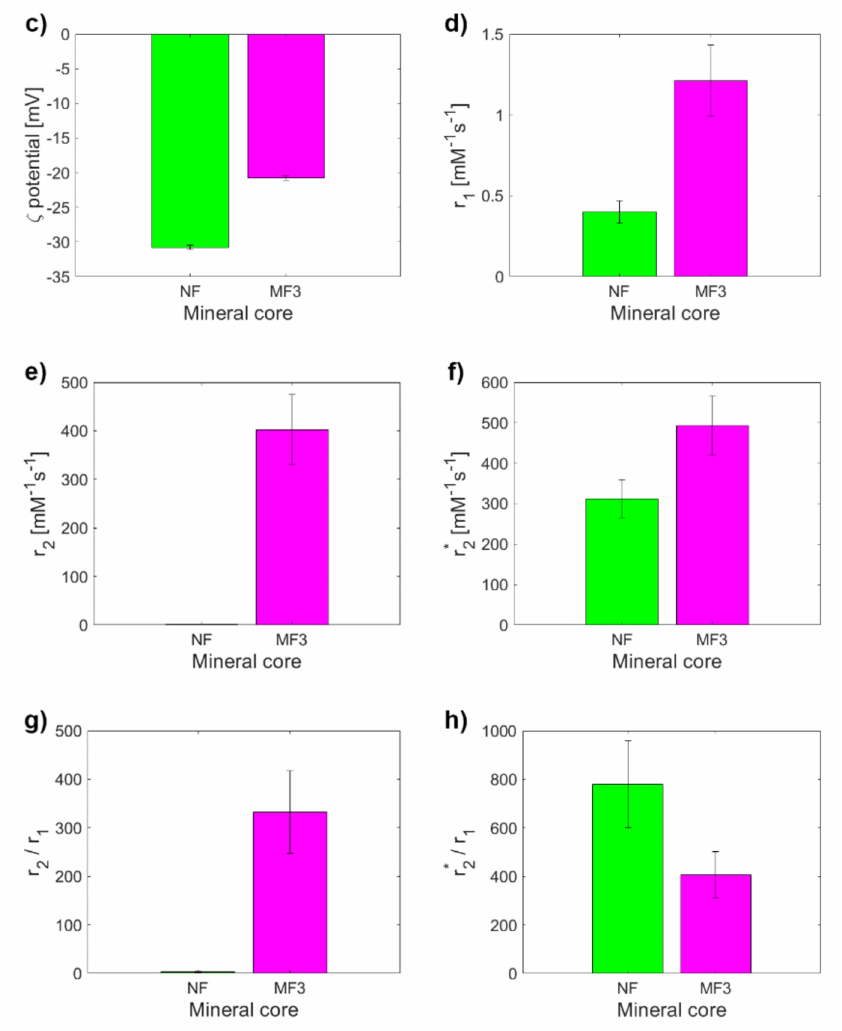
Figure 3. Comparison of the observed variables for NF and MF3, which have almost the same LF (868.00 vs. 873.00): ( a ) LF ; ( b ) D < HYDR > ; ( c ) ζ potential ; ( d ) longitudinal relaxivity r 1 ; ( e ) transverse relaxivity r 2 ; ( f ) transverse relaxivity r 2 * ; ( g ) relaxivity ratio r 2 /r 1 ; ( h ) relaxivity ratio r 2 * /r 1